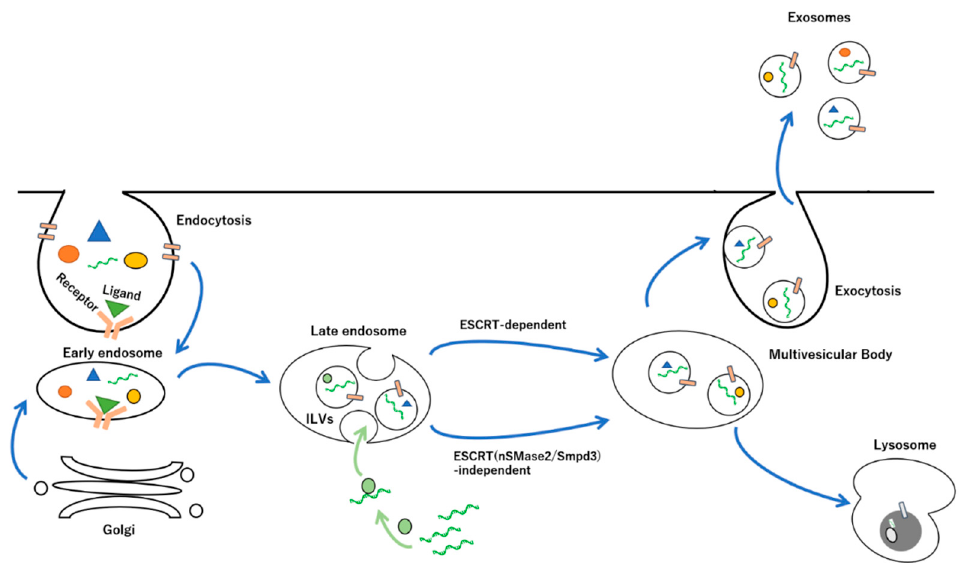
Figure 2 . Mechanisms of exosome biogenesis and secretion. Upon the binding of ligand with exosome, the endocytosis process involves inward budding of the cell membrane, which occurs at lipid rafts containing common membrane proteins, such as tetraspanins (e.g., CD9, CD81, CD63, etc.), MHC class I and class II, and adhesion molecules (e.g., integrins, cadherins, etc.). The internalized cargoes, including proteins, nucleic acids, and lipids are sorted into early endosomes, which mature into late endosomes. The intraluminal vesicles (ILVs) of the late endosomes are formed through budding from the perimeter membrane into the endosome lumen following the encompassing the bioactive molecules by ESCRT-dependent or -independent pathways. Multivesicular bodies (MVBs) containing some ILVs are selectively led into two different pathways, i.e., lysosomal degradation or secretion of exosomes toward the extracellular space through the fusion of lysosomes, or the plasma membrane in the case of exocytosis, which are regulated by the Rab GTPase family. miRNAs transcribed from nuclei are incorporated into the ILVs via interactions with RNA-binding proteins.